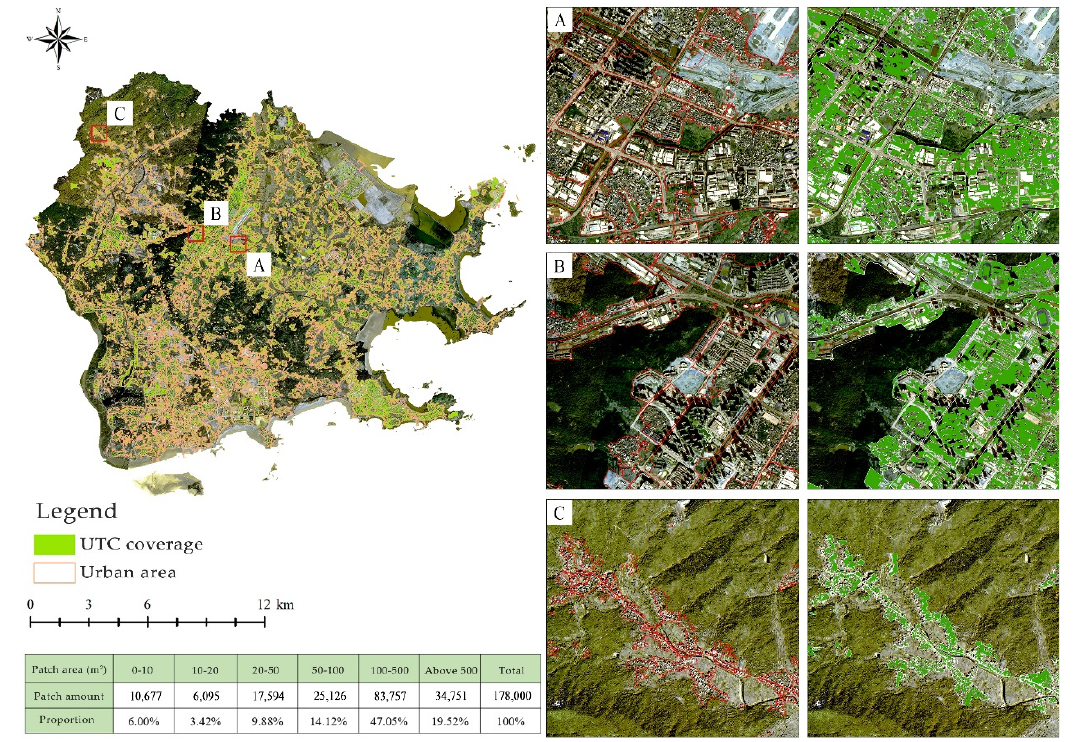
Figure 14. Detailed results of UTC coverage in the study area. ( A ) The center of city; ( B ) The suburban region of the city; ( C ) Outermost region of the city.